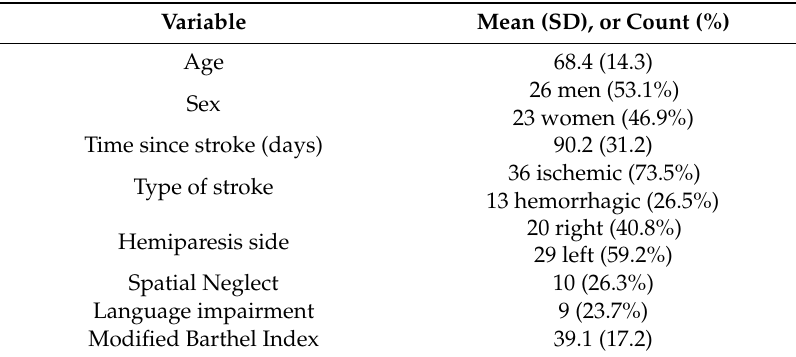
Table 1. Demographic and clinical characteristics of the sample ( n = 49).